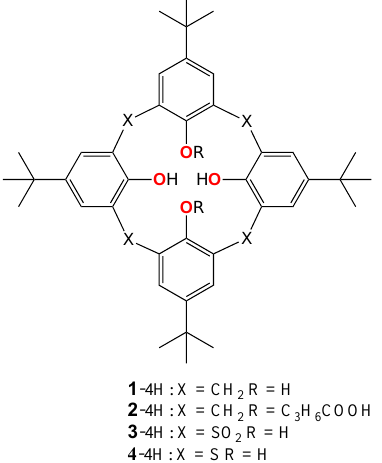
3 -4H: X = SO 2 R = H 4 -4H: X = S R = H Figure 1. Classical p- tert -butylcalix[4]arene ( 1 -4H), the targeted macrocyclic ligand ( 2 -4H), Tetrasulfonylcalix[4]arene ( 3 -4H) and thiacalix[4]arene ( 4 -4H).